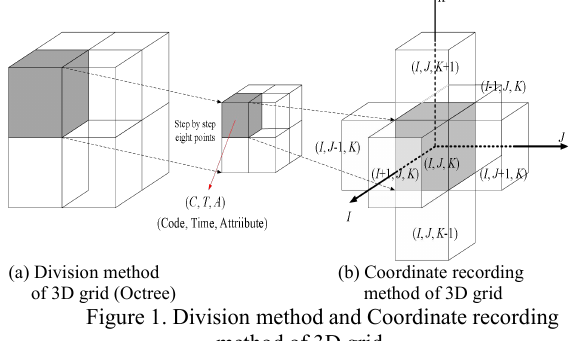
method of 3D grid Figure 1. Division method and Coordinate recording